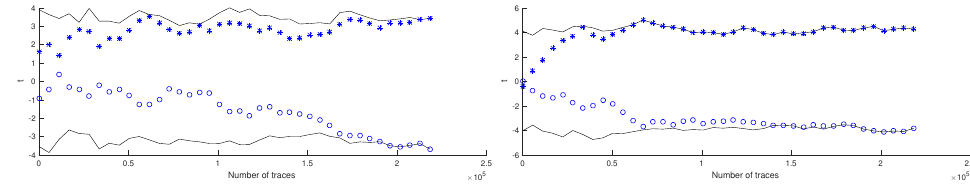
Figure 4: First order t growth for (3,1)- EPMult and (5,2)- EPMult with Exp-Log GF(2 8 ) multiplication. The black lines show the evolution of the maximum and minimum first-order t values over the number of traces. The stars mark how the index of the last maximum value grew over the number of traces. The circles mark the last minimum